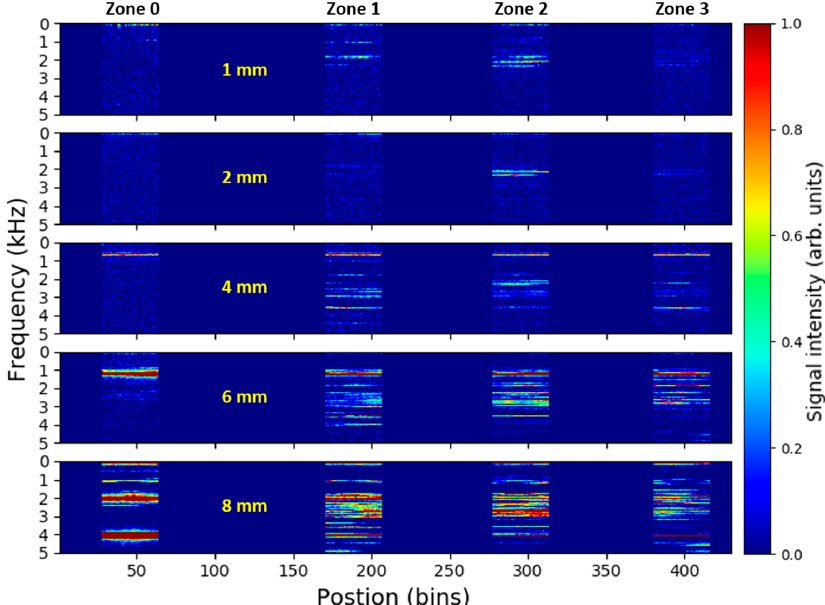
Figure 8. Time-averaged DAS signal spectra along the fiber recorded for different sizes of simulated leak at 10 bars. Signals from fiber dead-zones between the monitored pipe zones are discarded, i.e., set to